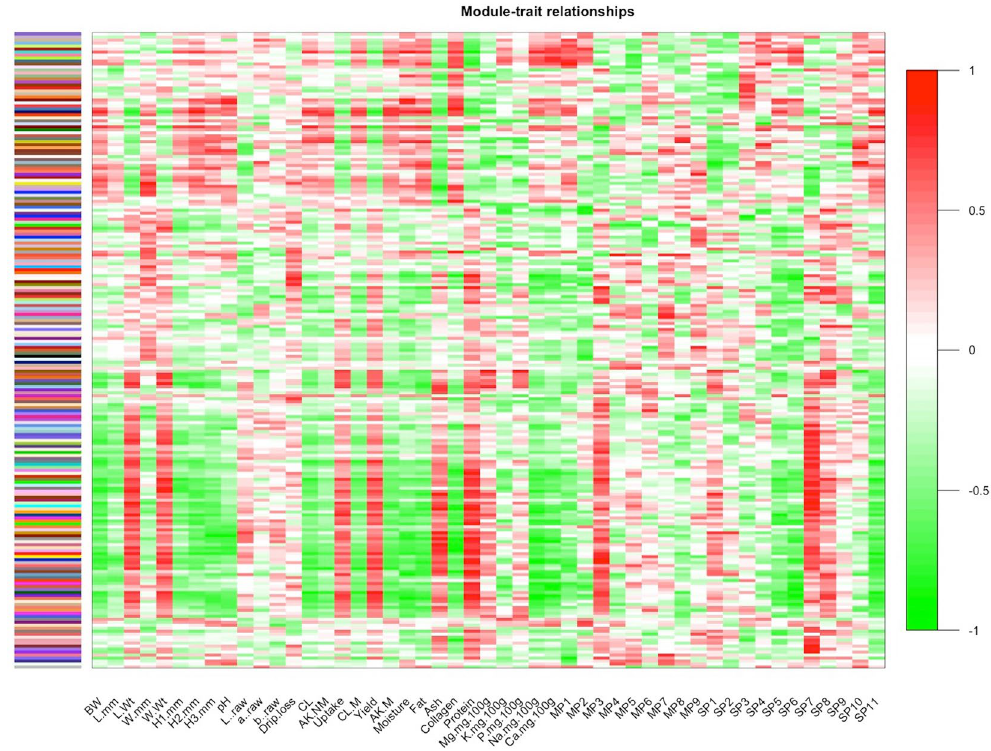
Figure 1. Heatmap representing associations between modules and traits (Module-trait relationships). Traits are reported on the x-axis, and modules are reported on the y-axis. The heatmap is color-coded by correlation values: green color represents a negative correlation, while red color represents a positive correlation. In the figure, “M” stands for Marinated meat, “NM” for Not Marinated, “MP” for Myofibrillar Protein, and “SP” for Sarcoplasmic protein. The complete explanation of the traits on the x-axis is reported in Zambonelli et al. 5